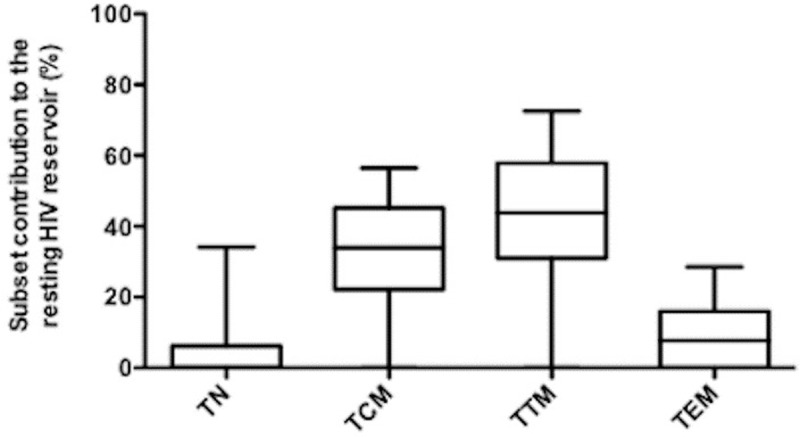
The CD4 T-cell subsets contribution to the resting HIV-2 reservoir considering both infection levels and frequency.Resting CD4 T-cells: naive (TN; CD45RA+CCR7+CD27+) central-memory (TCM; CD45RA-CCR7+CD27+) transitional memory (TTM; CD45RA-CCR7-CD27+) and effector-memory cells (TEM; CD45RA-CCR7-CD27-) are represented from 14 HIV-2 infected subjects. The results are expressed as the median percentage of the resting CD4 T-cells HIV-2 reservoir, with interquartile range [25%–75%] and minimum and maximum values.